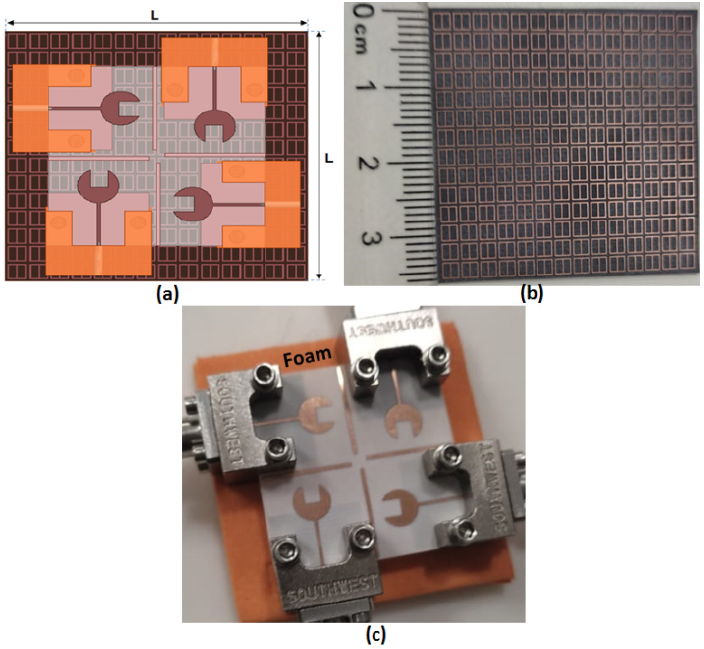
Figure 20. The suggested 4-port MIMO antenna ( a ) 2D layout ( b ) The fabricated photo of 14 × 14 FSS cells ( c ) The fabricated prototype loaded with FSS cells.